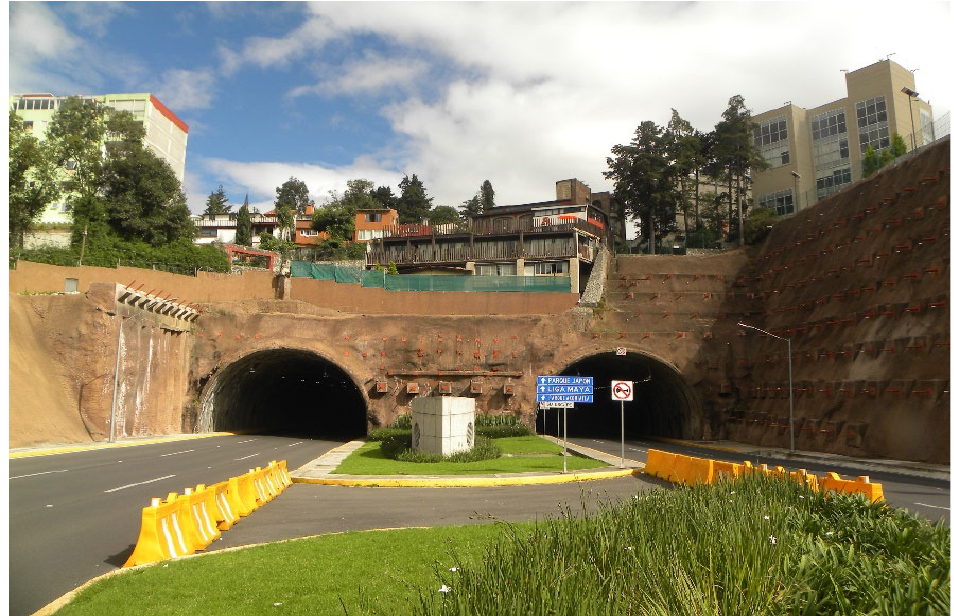
Figure 40. Panoramic view of the South Portal of El Desierto de los Leones Tunnel in 2020.